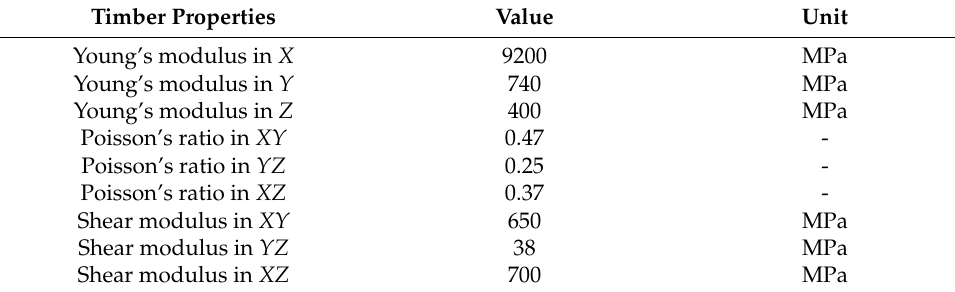
Table 2. Elastic constants of the material model for timber.